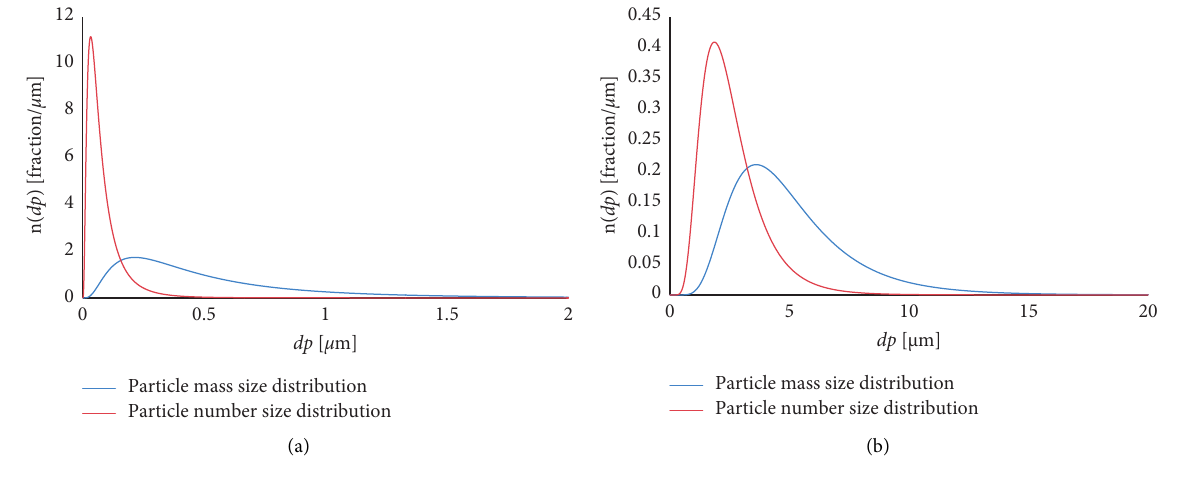
Figure 2: Particle mass and number size distribution functions of (a) PM2.5 and (b)